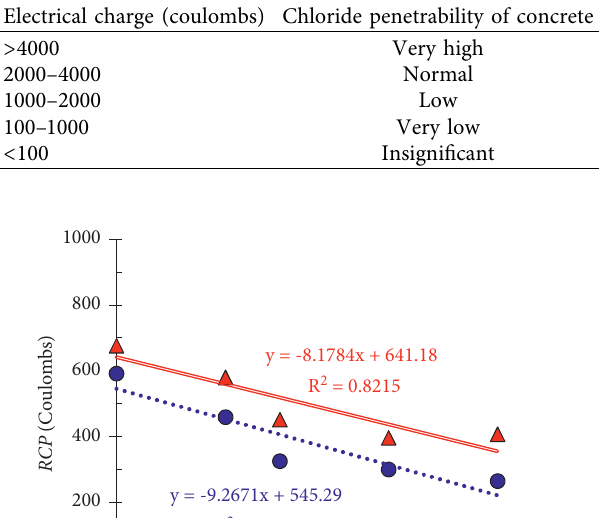
Table 4: Electrical indication of chloride durability [66]. Electrical charge (coulombs) Chloride penetrability of concrete